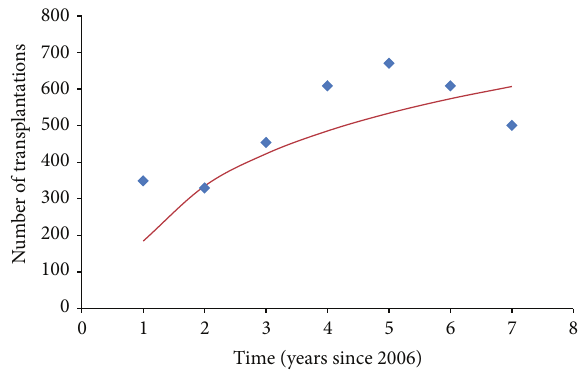
Figure 2: Fitting curve by the method of maximum likelihood [4] to the data from Table 2 to project the number of transplantations, 𝑇𝑟 , in the future (after MELD).